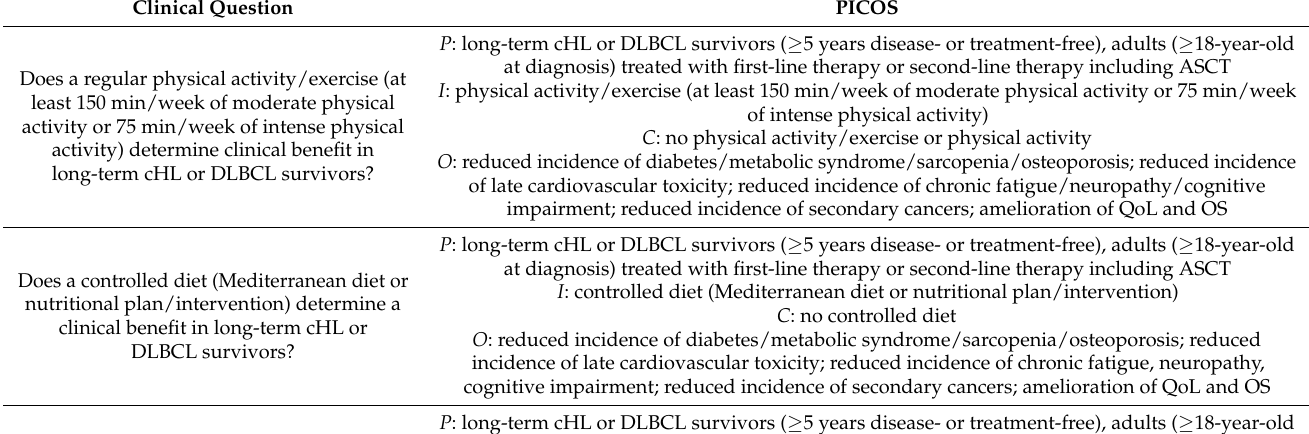
Table 1. Clinical questions and PICOS addressed by the systematic review: healthy lifestyles and survivorship care plans. Clinical Question